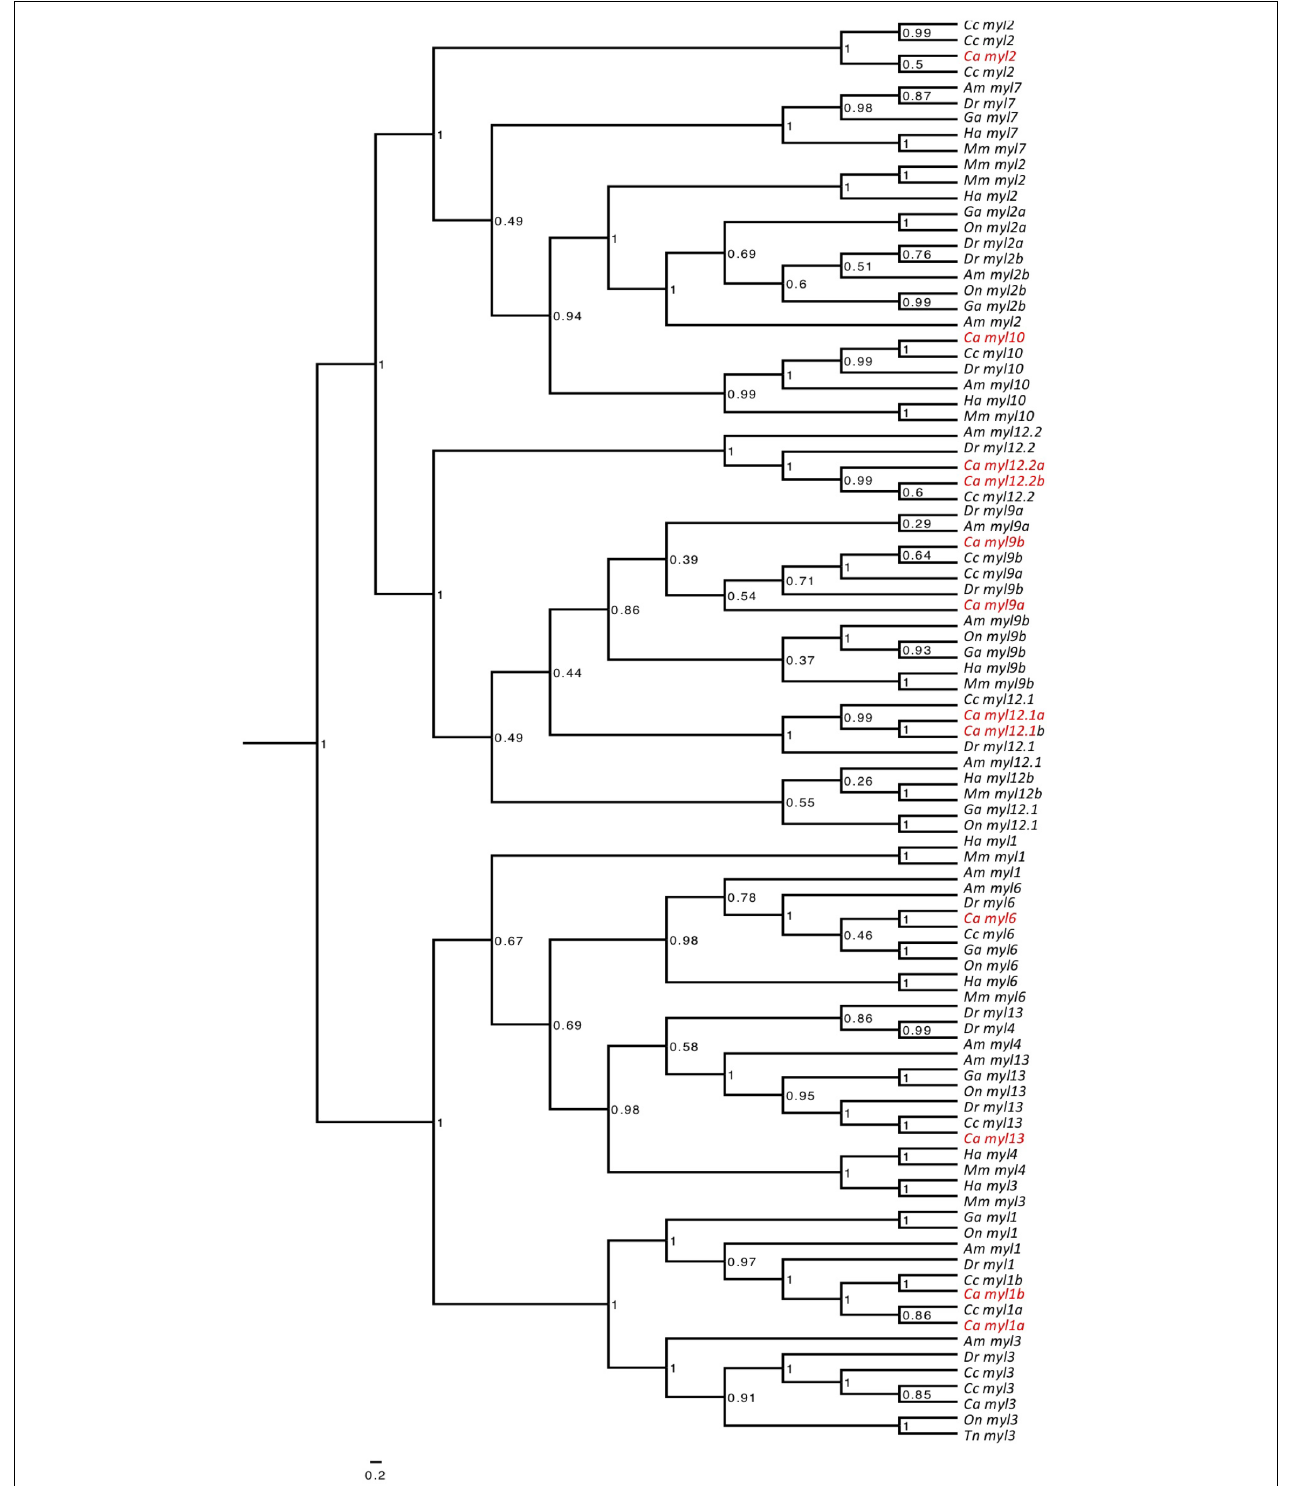
FIGURE 2 | Phylogenetic tree constructed for myosin light chain genes. Bayesian phylogenetic relationships for the myosin light chain orthologs. Phylogenetic tree node numbers represent posterior values. To ease interpretation, goldfish orthologs ( Carassius auratus, Ca ) are highlighted in red. Myosin heavy chain orthologs for zebrafish ( Danio rerio, Dr ), stickleback ( Gasterosteus aculeatus, Ga ), common carp ( Cyprinus carpio, Cc ), green spotted pufferfish ( Tetraodon nigroviridis, Tn ), tilapia ( Oreochromis niloticus, On ), cavefish ( Astyanax mexicanus , Am ), medaka ( Oryzias latipes, Ol ) and human ( Homo sapiens, Ha ) were also included.